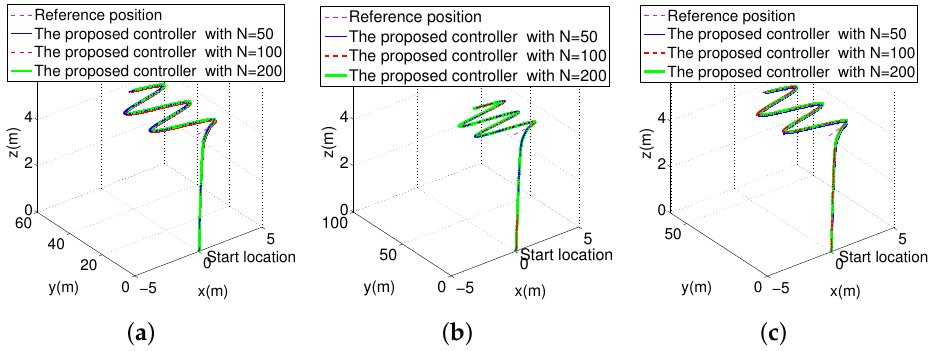
Figure 6. AUV 3D position tracking under various ensemble (N) sizes and noise levels (T = 0.01 s): ( a ) noise case 1, ( b ) noise case 2, and ( c ) noise case 3. Table 3. RMS errors (m) at steady state, using the proposed controller under various ensemble sizes ( T = 0.01 s). Case 1 Ensemble (N)